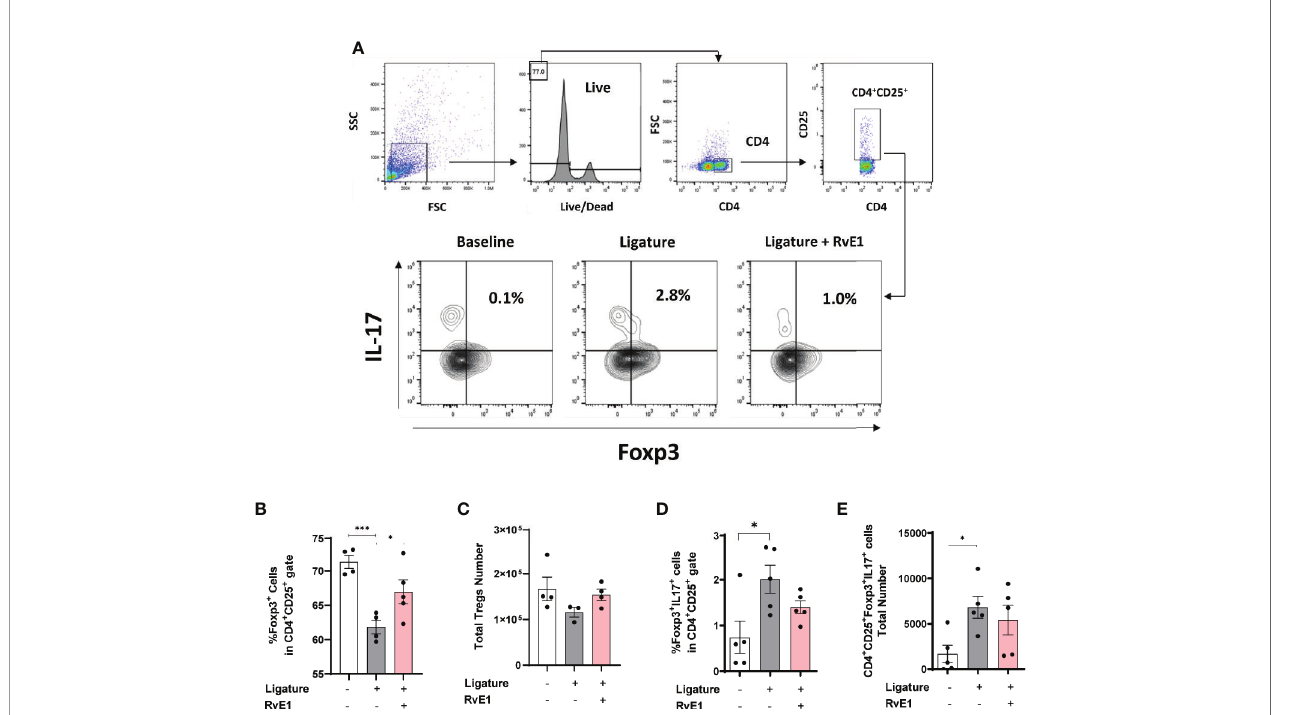
FIGURE 6 | Impact of delayed RvE1 administration on Treg cellsfrom cervical lymph nodes. (A) Representative plots indicating the gating strategy andpercentageof CD4 + CD25 + Foxp3 + IL17 + cells in cervicallymph nodes ofanimals at baseline, with ligature-induced periodontitis(Ligature),or treated with RvE1 fromday 1 (RvE1). (B) Quanti fi cation of the percentage and (C) totalnumber of Treg cells. (D) Quanti fi cation of the percentage and (E) cell number of IL-17 + Treg cells. *P < 0.05, ***P <